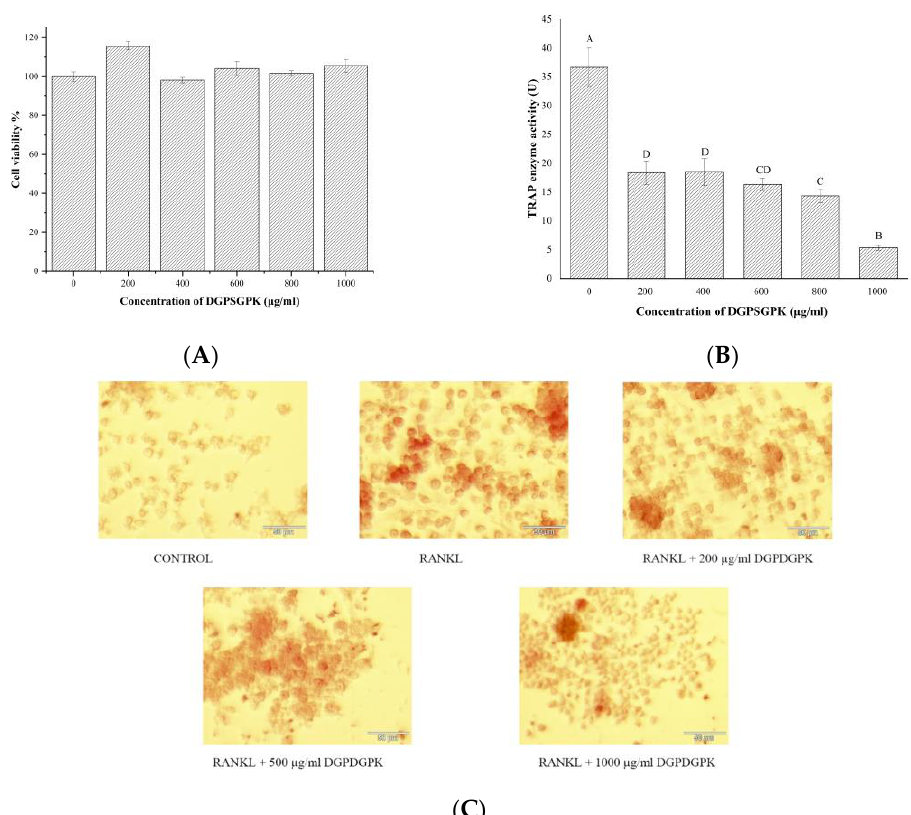
Figure 10. Effects of DGPSGPK with different concentrations on osteoclast differentiation. ( A ) Cell viability. ( B ) TRAP activity. ( C ) TRAP staining.